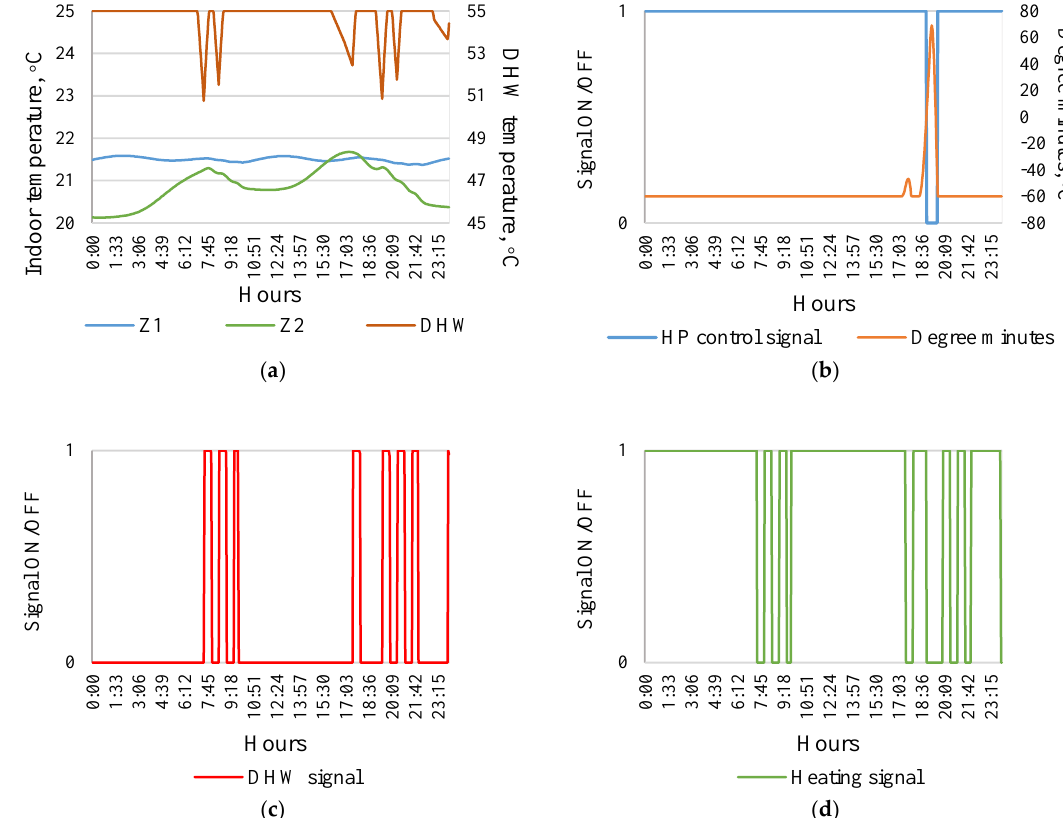
Figure 9. ( a ) Indoor temperature and domestic hot water (DHW) supply temperature, ( b ) GSHP control and degree minute (DM) value ( c ) only DHW signal, ( d ) only heating signal for a single-family house occupied by four people.